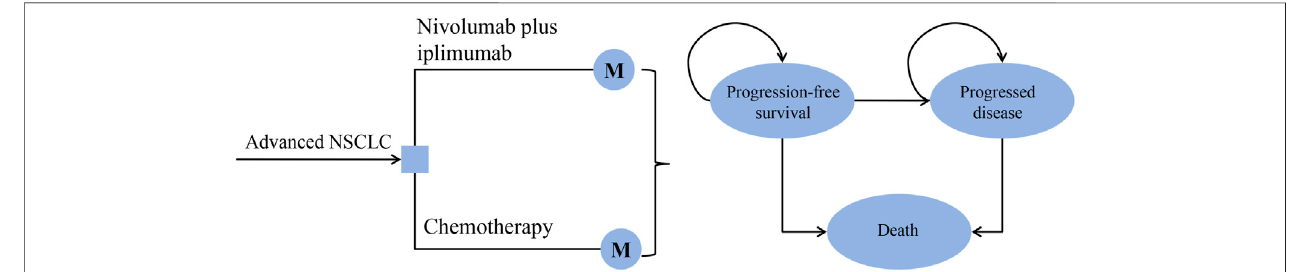
FIGURE 1 | The decision tree and the Markov state transition model. NSCLC: non-small-cell lung cancer.